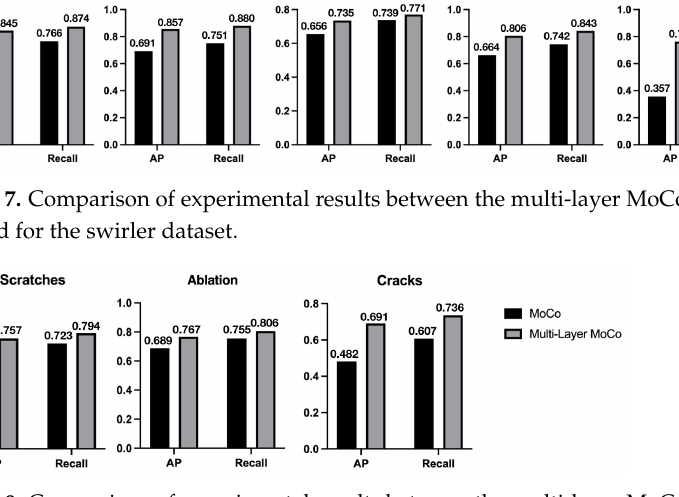
Figure 8. Comparison of experimental results between the multi-layer MoCo method and the MoCo method for the large elbow pipe dataset.